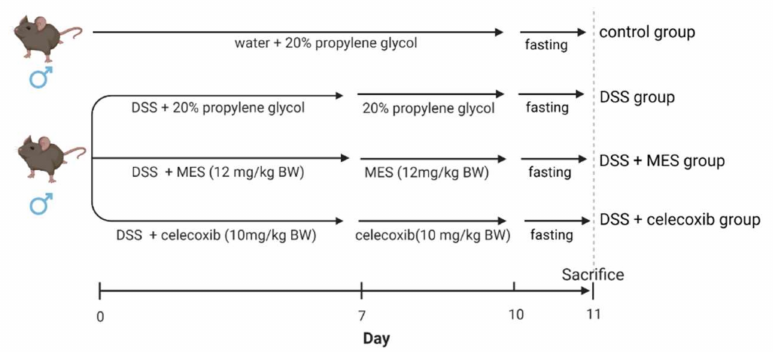
Figure 1. Experimental design. Mice were given 4% DSS in drinking water for 7 days to induce colitis. MES (12 mg/kg BW) or celecoxib (10 mg/kg BW) was given for 10 days. DSS: dextran sulfate sodium; MES: meroterpenoid-rich ethanoic extract of a brown algae, Sargassum macrocarpum